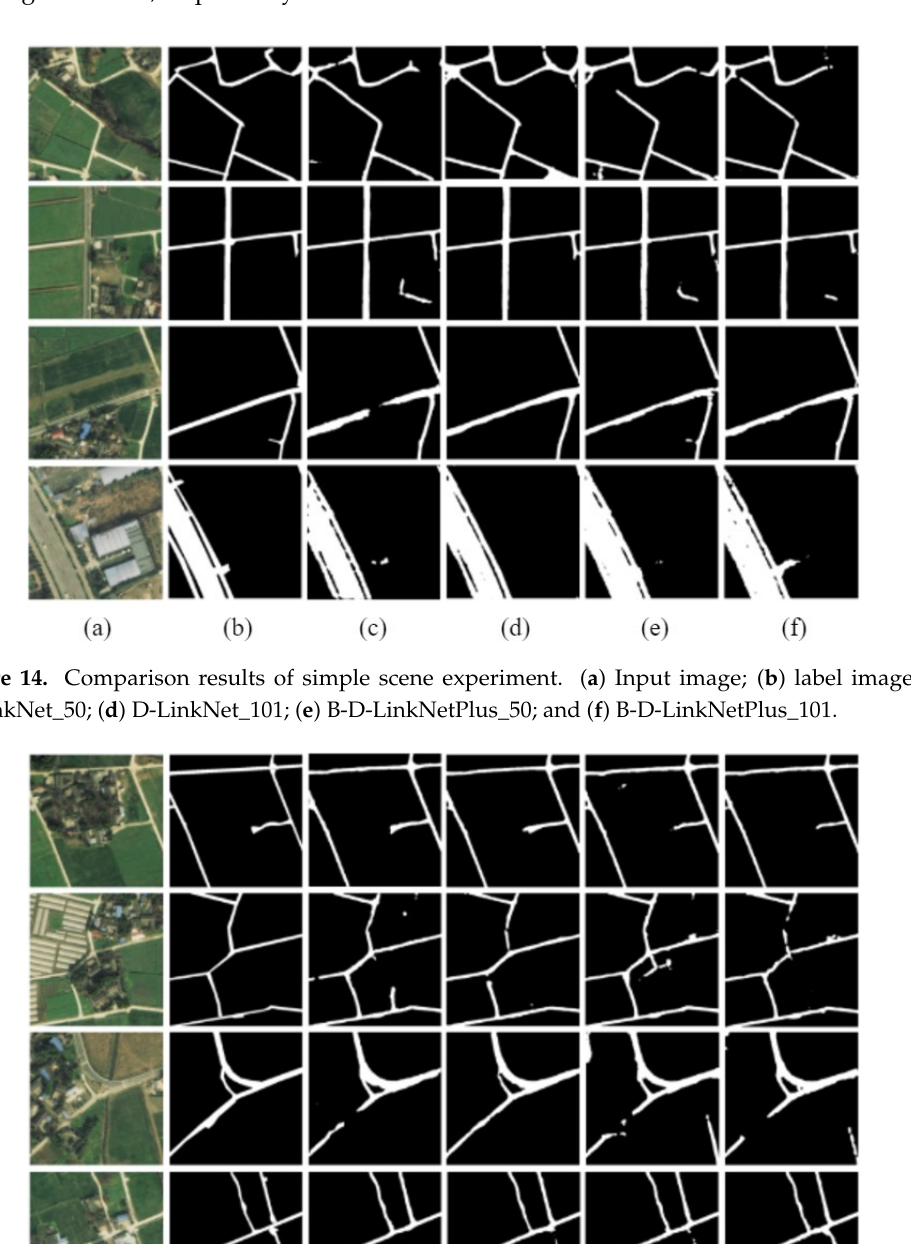
Figure 16. Comparison results of complex scene experiment. ( a ) input image; ( b ) label image; ( c ) D- LinkNet_50; ( d ) D-LinkNet_101; ( e ) B-D-LinkNetPlus_50; and ( f ) B-D-LinkNetPlus_101. As seen in Figure 16, whether using D-LinkNet or B-D-LinkNetPlus, the overall image road detection results are very close to the manual label images. However, in terms of broken road connection, D-LinkNet and B-D-LinkNetPlus are better than D-LinkNetPlus. With regard to the last